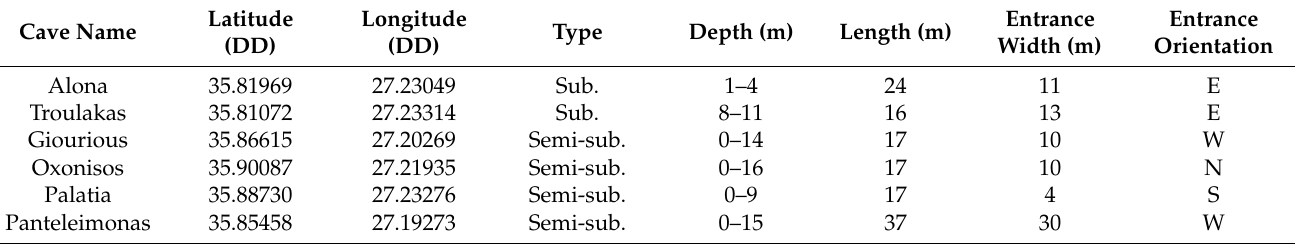
Table 1. Geomorphological and topographic characteristics of the six studied marine caves. Sub., fully submerged; Semi-sub.,